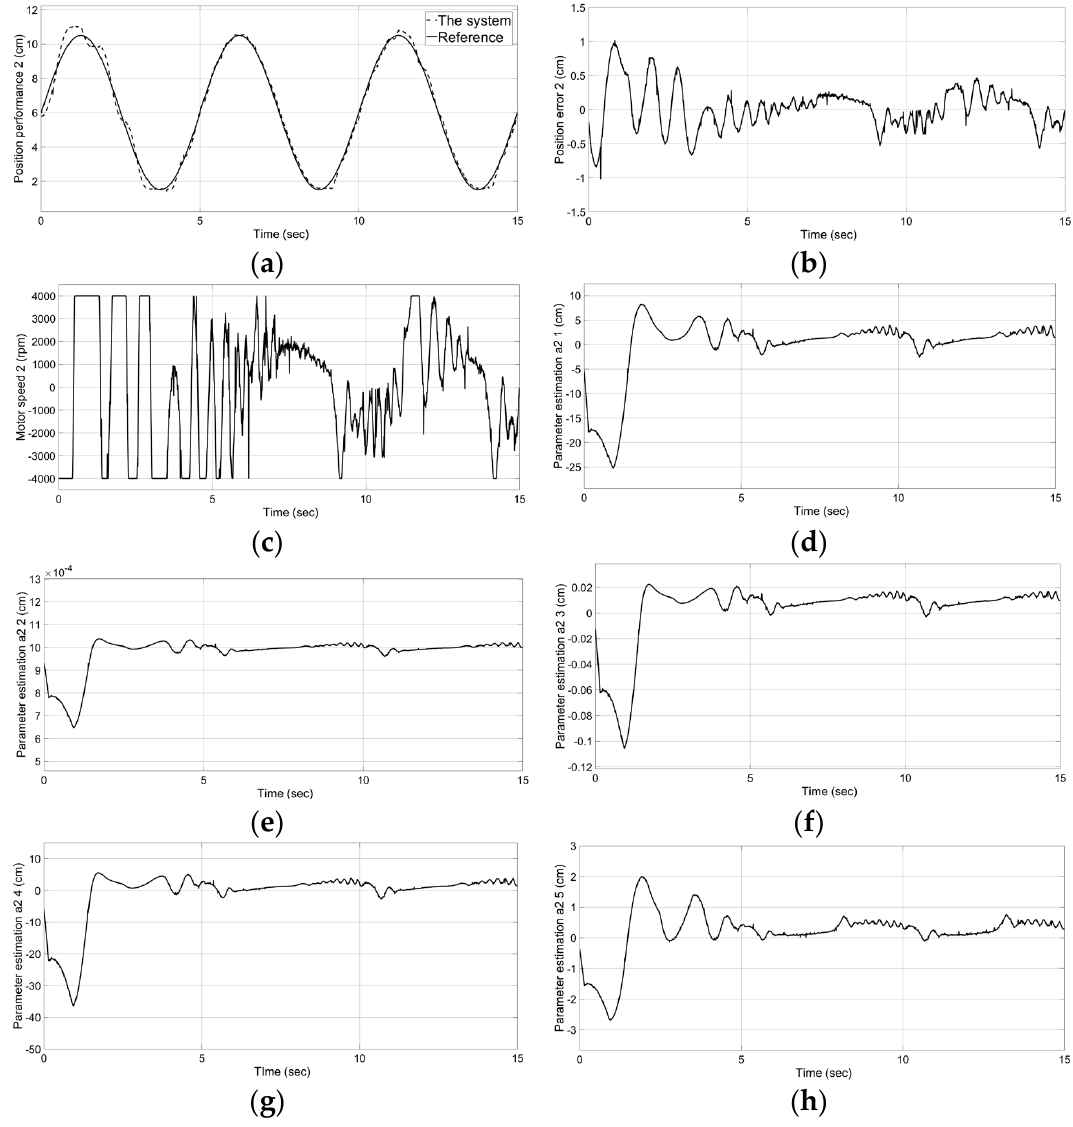
Figure 8. Experimental tracking responses with a 15 kg mass: ( a – c ) describe the position performance of the EHA in cm, the tracking error in cm, and the rpm of the motor. ( d – h ) are estimation parameters in cm.